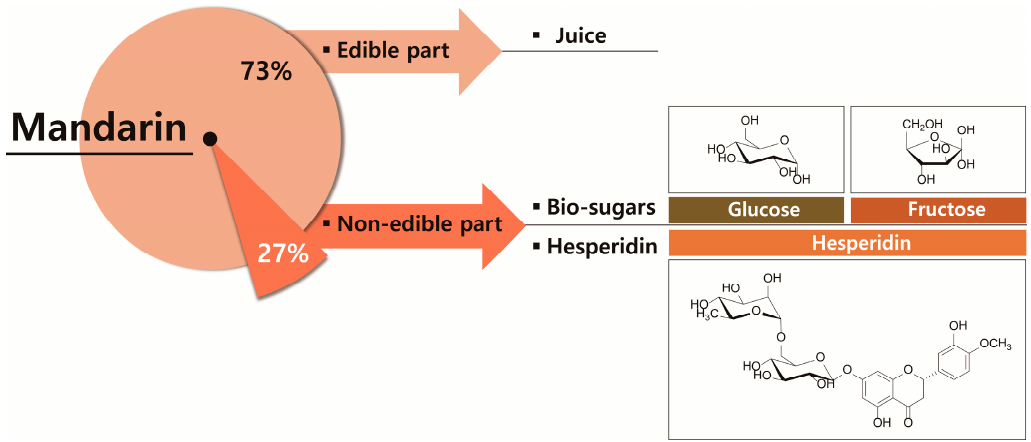
Figure 1. Process for production of valuable products from mandarin peel waste (MPW).